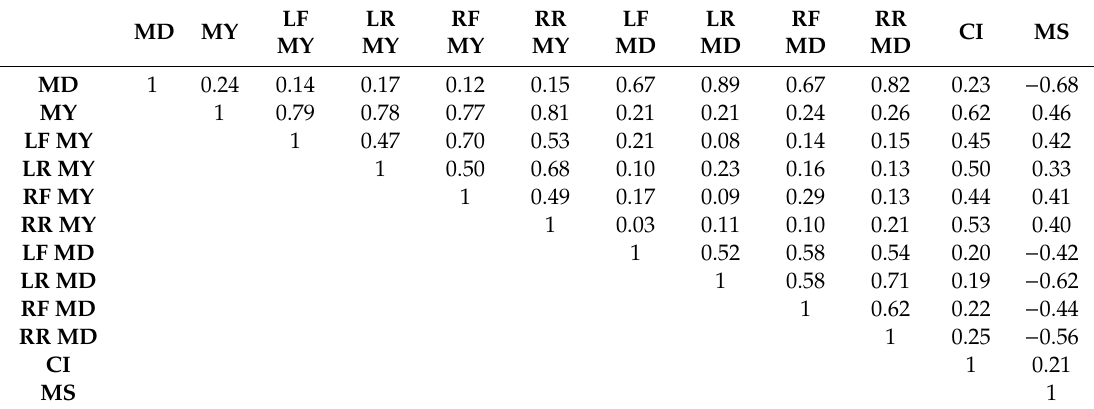
Table 9. Pearson’s correlation coe ffi cients of considered traits for single milkings.